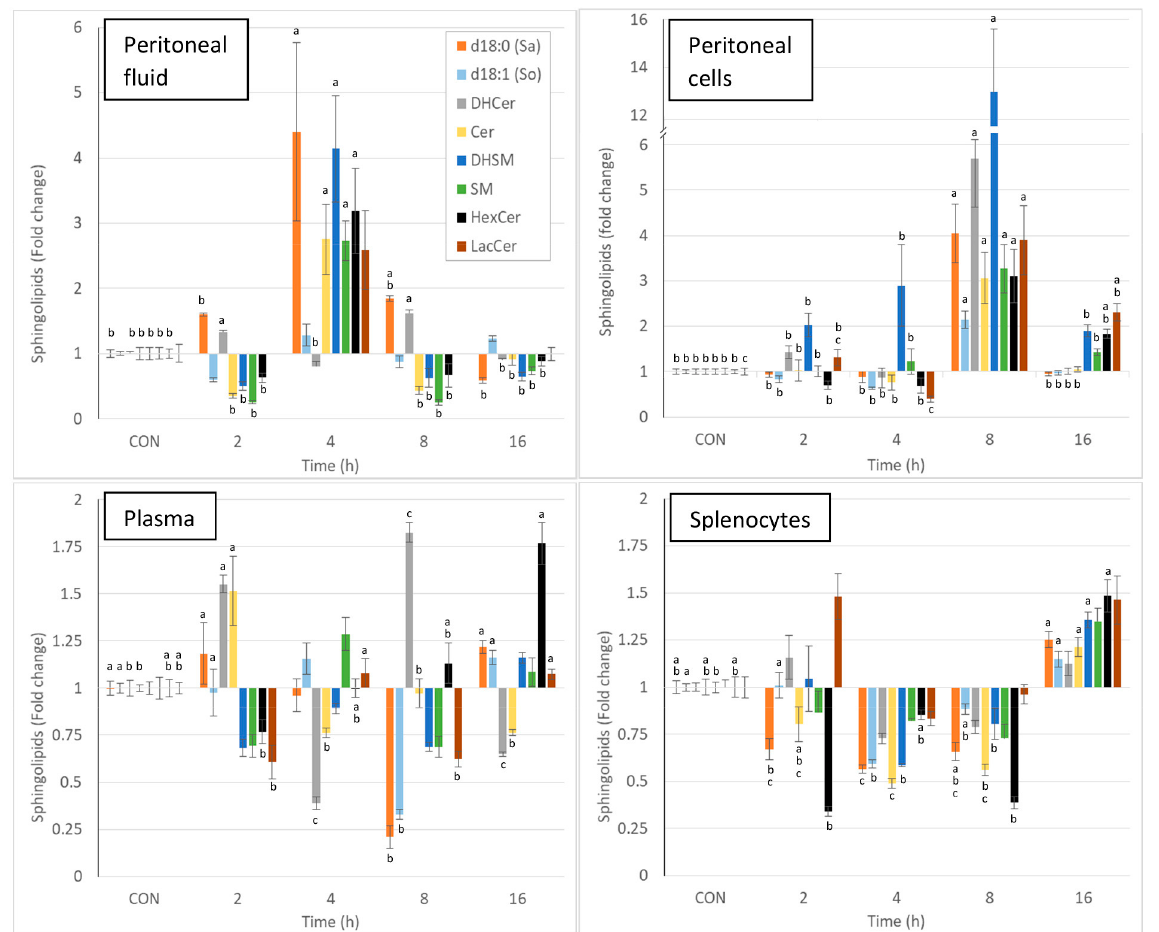
Figure 3. Effect of intraperitoneal administration of zymosan at a dose of 0.1 mg/mouse on the different classes of sphingolipids expressed as fold-increase vs. the values measured in controls (CON) that received PBS only. Values are reported as means ± SE, n = 16 for the controls and n = 4, 4, 4, and 8 for the mice treated at 2, 4, 8, and 16 h post-zymosan injection, respectively. Significant differences among groups were investigated using one way ANOVA. Statistically different groups (Duncan) were then identified using different apex letters ( p < 0.05). Any two means having a common letter are not significantly different at the 5% level of significance.